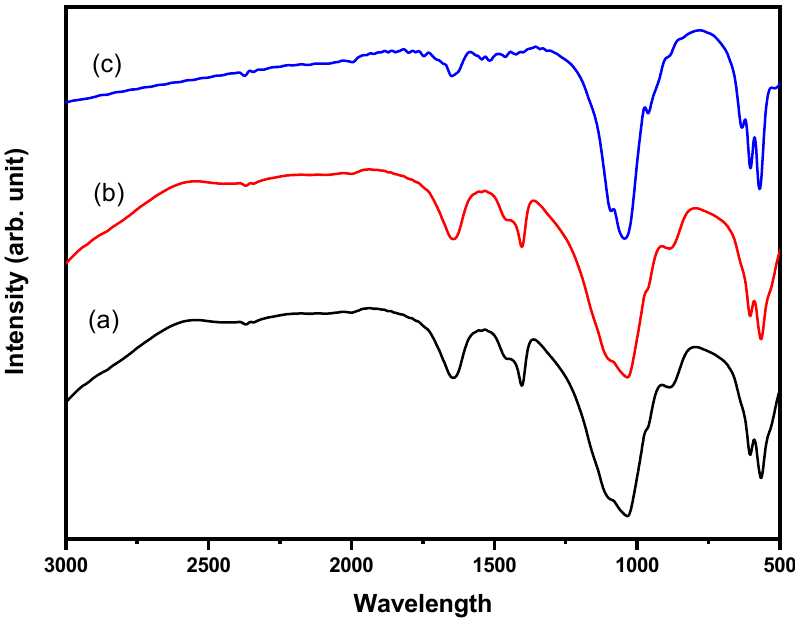
Figure 1. FTIR of HAp synthesized by ( a ) microwave, ( b ) coprecipitation, and ( c ) sol–gel. The FTIR results agreed with the FTIR analysis reported in the literature.